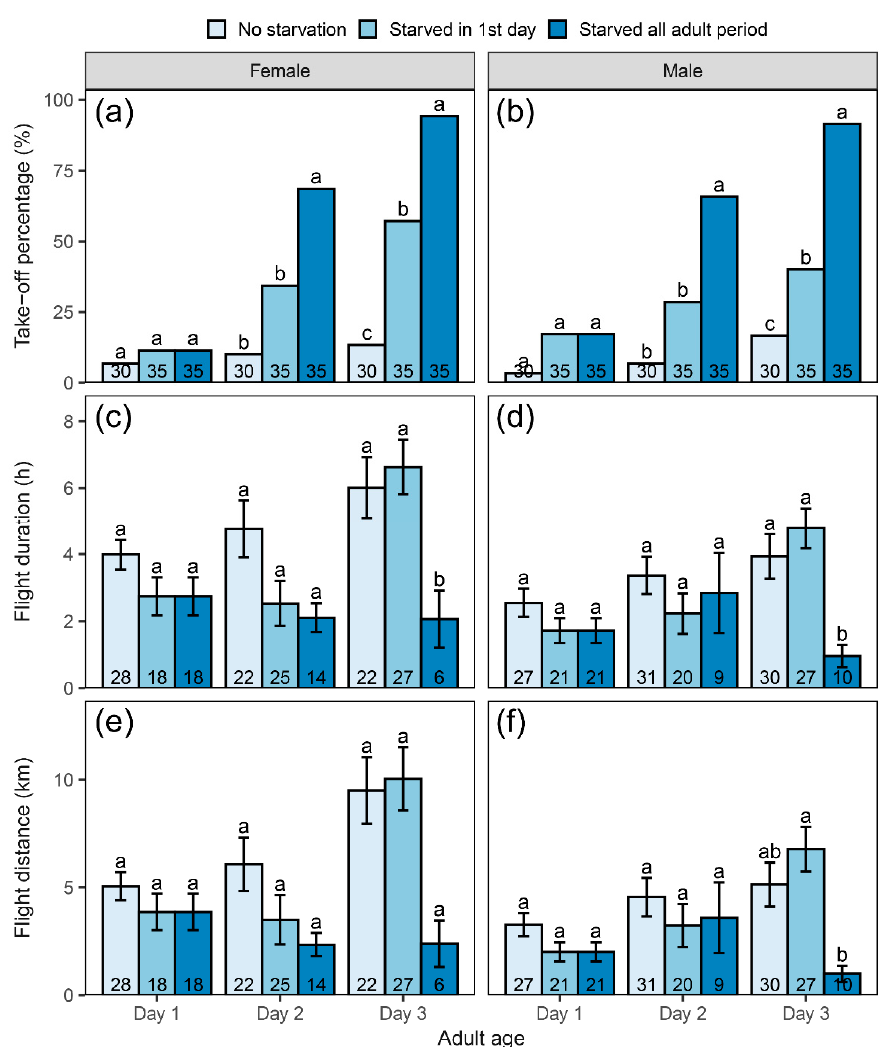
Figure 2. Flight responses of 1-3-day-old female and male adults after starvation . Different letters above the bars indicate significant differences between different treatments ( p < 0.05), based on the result of chi-square test for take-off percentage and Tukey’s HSD tests for flight duration and distance. The numbers in the bars indicate sample sizes. ( a ) The take-off percentage of female moths. ( b ) The take-off percentage of male moths. ( c ) The flight duration of female moths. ( d ) The flight duration of male moths. ( e ) The flight distance of female moths. ( f ) The flight distance of male moths.